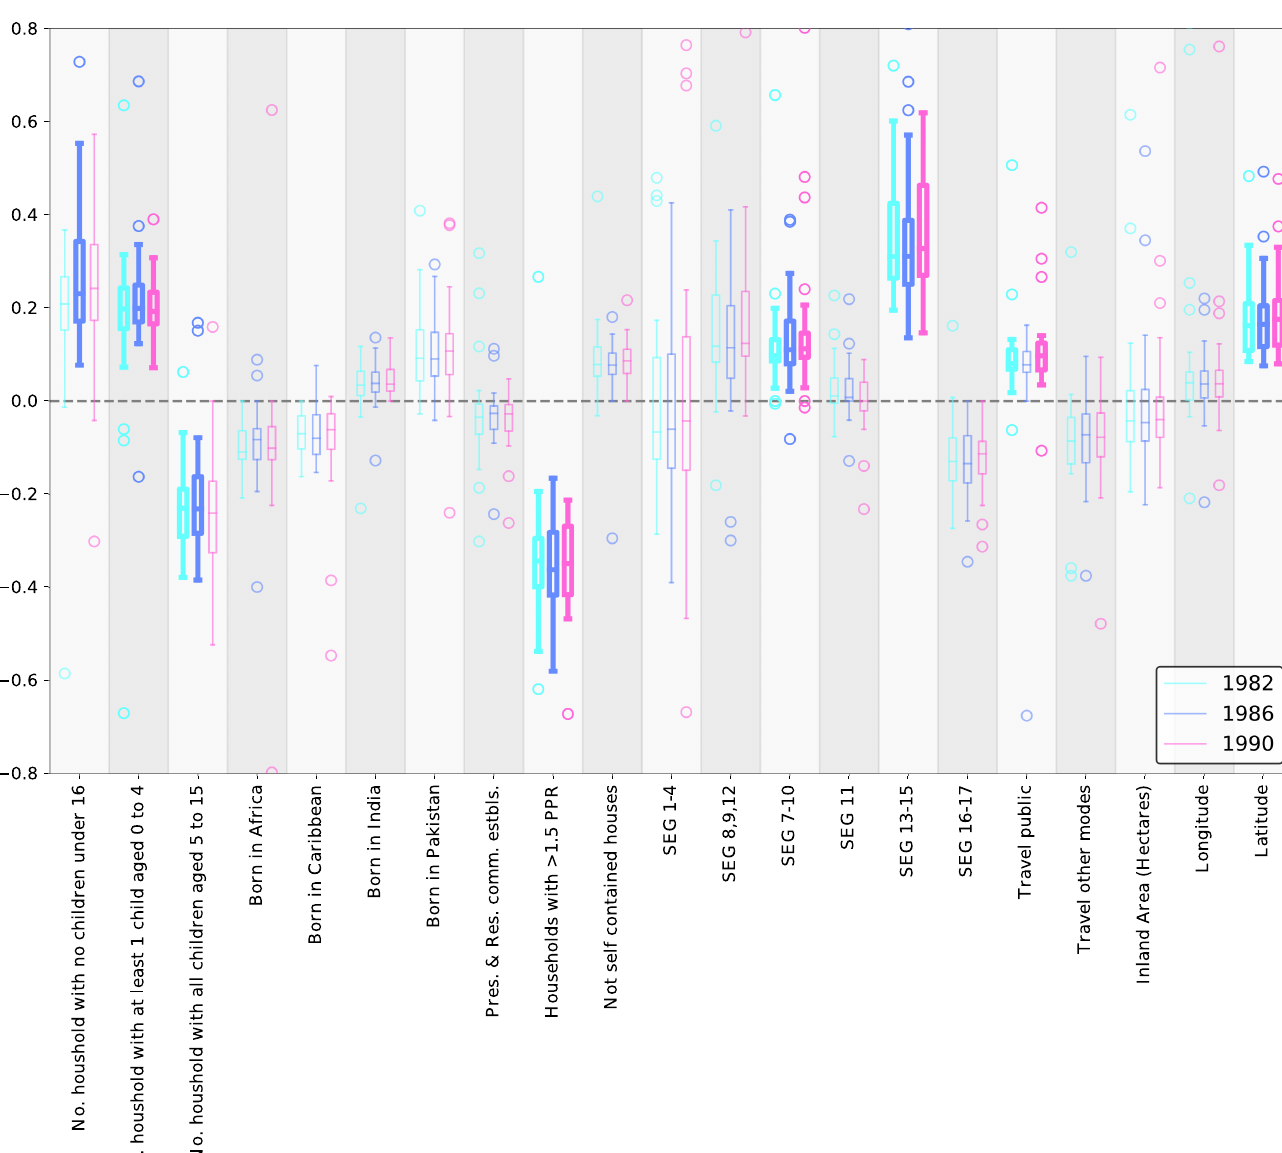
Fig 5. Aggregated SHAP values, representing the marginal contribution of each feature to predicted phase lags by the FFNN model. After fitting the FFNN model on the entire dataset, local SHAP values are obtained for each data point and aggregated over each time snapshot, distinguished with different colors. Values plotted in bold indicate statistical